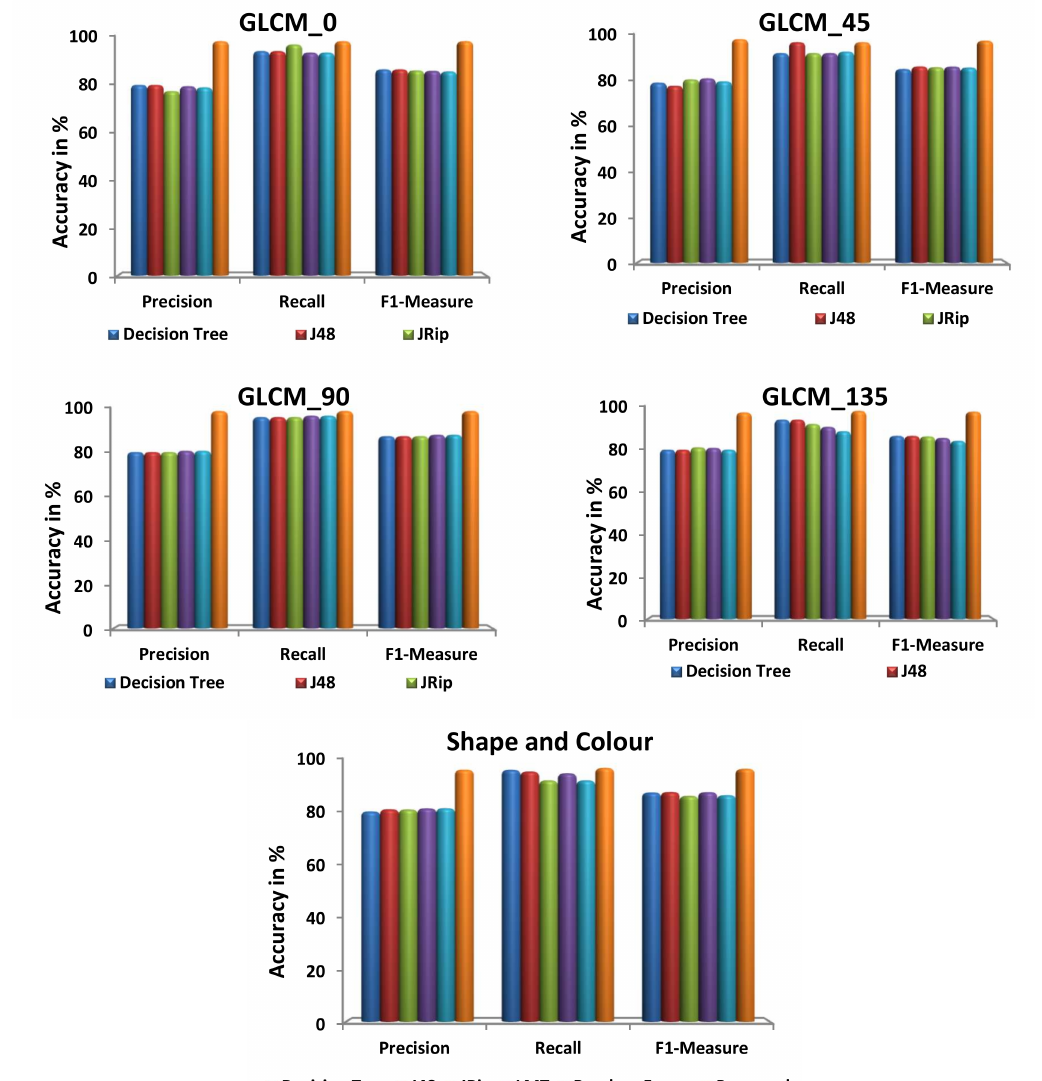
Figure 9. Evaluation of various prediction